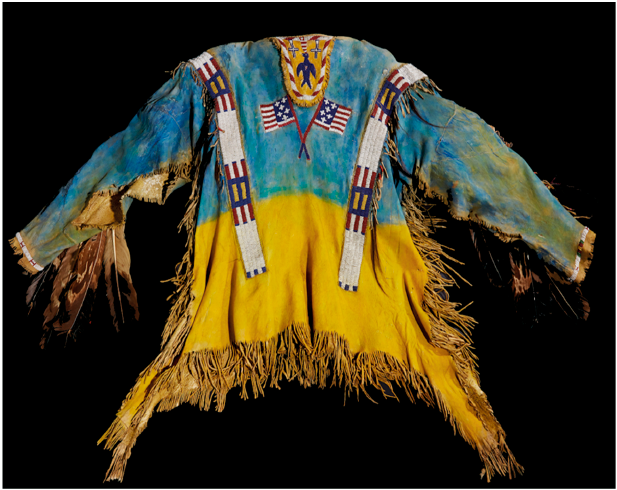
Figure 6. Rear view of Plains Indian buckskin tunic, c. 1888, beadwork, eagle feathers, paint, and quillwork on deerskin. Mus é e de l’Atelier Rosa-Bonheur, Ch â teau de By, Thomery, France. Photograph taken by Christie’s Paris. Used by permission of the Mus é e de l’Atelier Rosa-Bonheur. Arts 2019 , 8 , x FOR PEER REVIEW